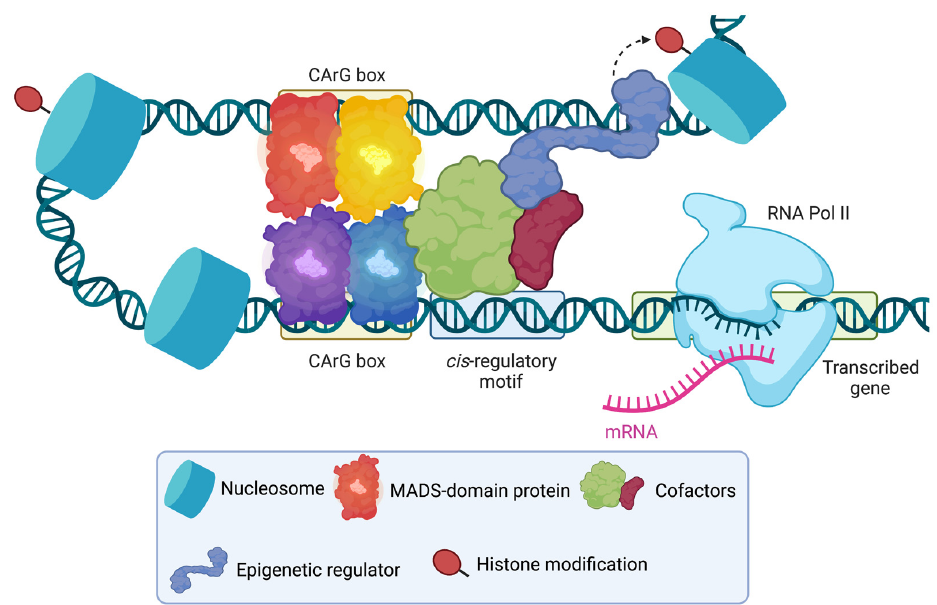
Figure 2. Possible mechanisms for floral organ identity factor function. Two dimers of MADS-do- main proteins bind to adjacent CArG boxes. The formation of a tetrameric complex as a result of the interaction of the two dimers leads to looping of the interjacent DNA [16,52]. Cofactors bind to cis - regulatory elements in the vicinity of CArG-boxes and interact with the floral organ identity factors, the transcriptional machinery, and/or recruit epigenetic regulators, which can alter chromatin struc- ture and accessibility, e.g., by making post-translational modifications to histones. Figure created with